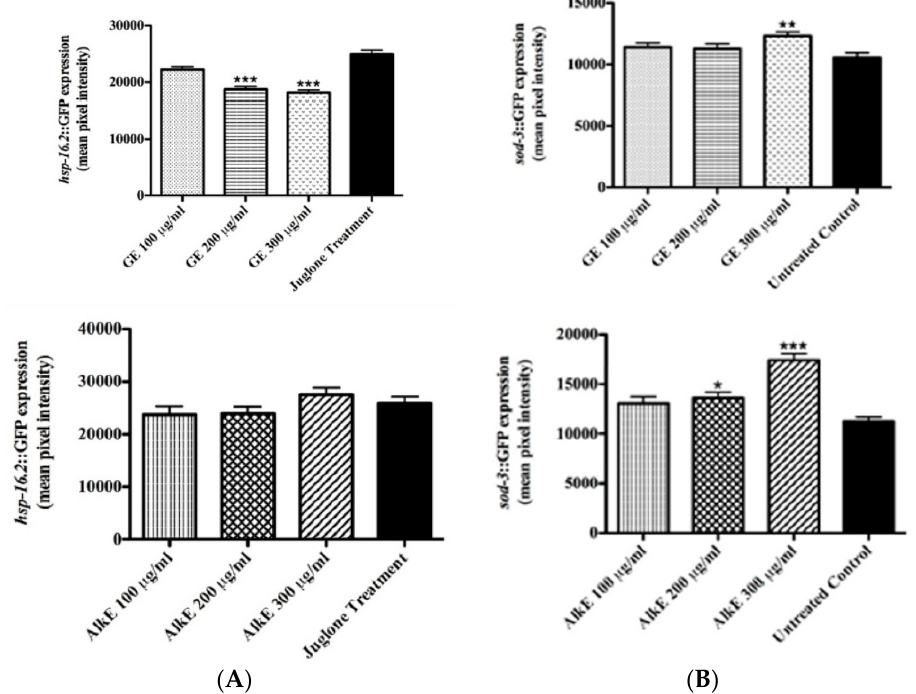
Figure 3. Effect of GE or AlkE treatment on the expression of stress resistance related genes. ( A ) Heat shock protein 16.2 (HSP ‐ 16.2) expression in the mutant strain TJ375 [hsp ‐ 16.2::GFP(gplsI)] under juglone ‐ induced oxidative stress. The hsp ‐ 16.2 expression levels were significantly decreased by GE treatment compared to the untreated control. No significant effect was observed among worms treated with the alkaloid extract, AlkE. ( B ) Superoxide dismutase 3 (SOD ‐ 3) expression in the mutant strain CF1553 after treatment with GE and AlkE. Worms [(pAD76)sod ‐ 3p::GFP + rol ‐ 6] treated with 300 μ g/mL of GE showed higher levels of SOD ‐ 3 expression compared to the control. Similar results were observed among worms treated with the alkaloid extract, AlkE. The results are presented as mean ± SEM from three independent experiments. * p <0.05, ** p <0.01, *** p < 0.0001 compared to the untreated control by one ‐ way ANOVA followed by Bonferroni’s method (post ‐ hoc).